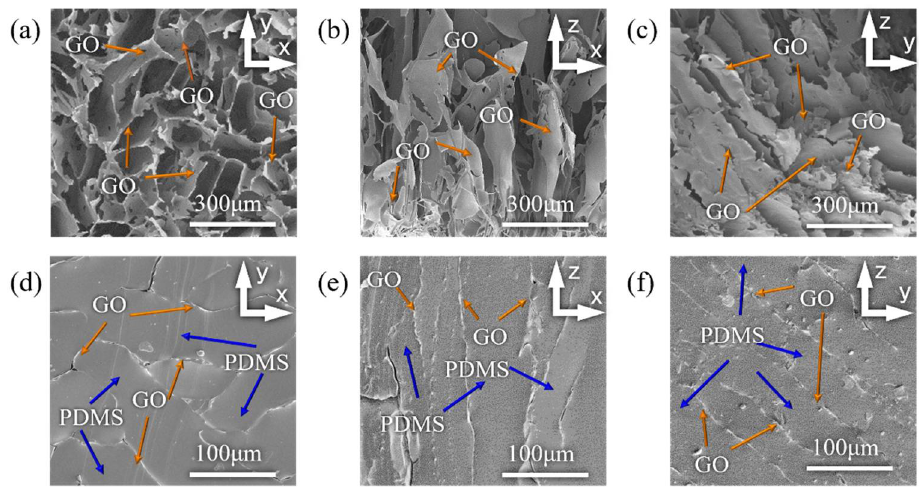
Figure 3. Morphology of GO foam and 3D GO-PDMS composite. ( a – c ) shows the three-dimensional structure of GO foam in three directions; ( d – f ) shows that the PDMS matrix is well infiltrated into the skeleton of GO foam in all directions.